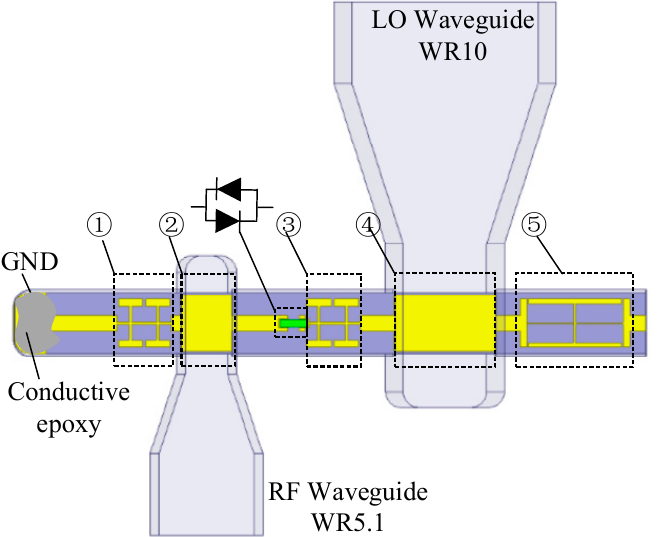
Figure 1. The proposed novel circuit topology.